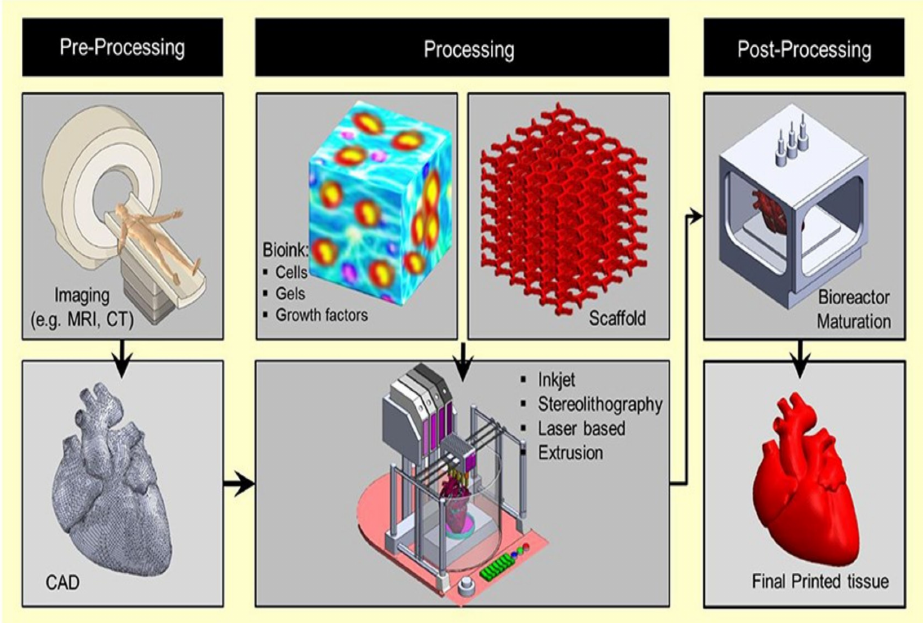
Figure 6. Schematic representation of bio-printing process. Reprinted with permission from